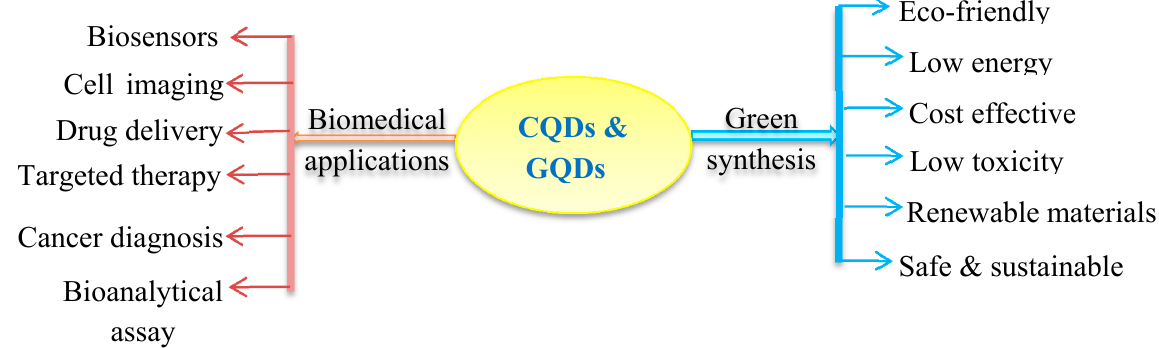
Figure 1. Chart of green synthetic methods of quantum dots (carbon quantum dots (CQDs) and graphene quantum dots (GQDs)) and their biomedical applications.